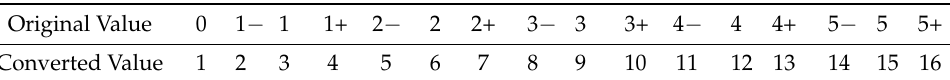
Table 2. Muscle strength feature